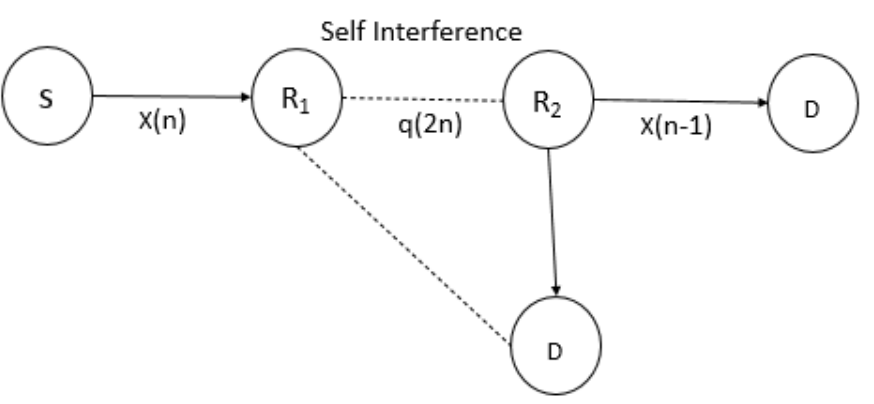
Figure 3. Transmission of signals in 2 n th time slot.